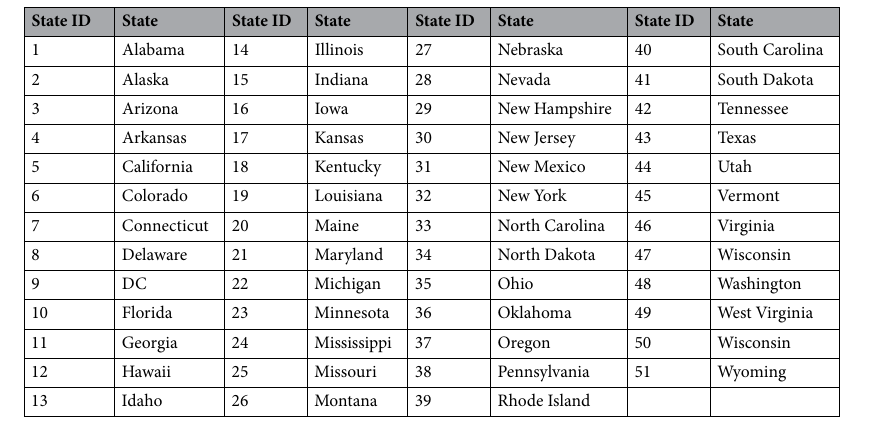
Table 1. The IDs associated with each US State used in this